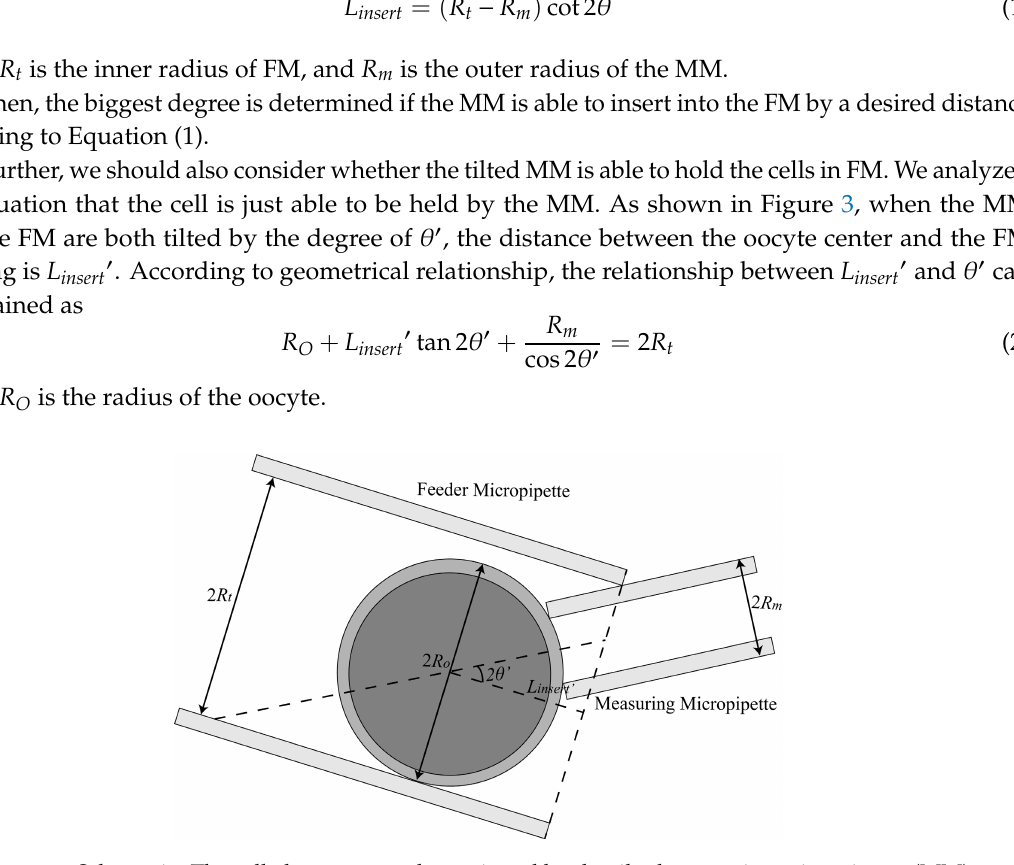
Figure 2. Schematic: The tilted measuring micropipette (MM) is just able to insert into the tilted feeder micropipette (FM).